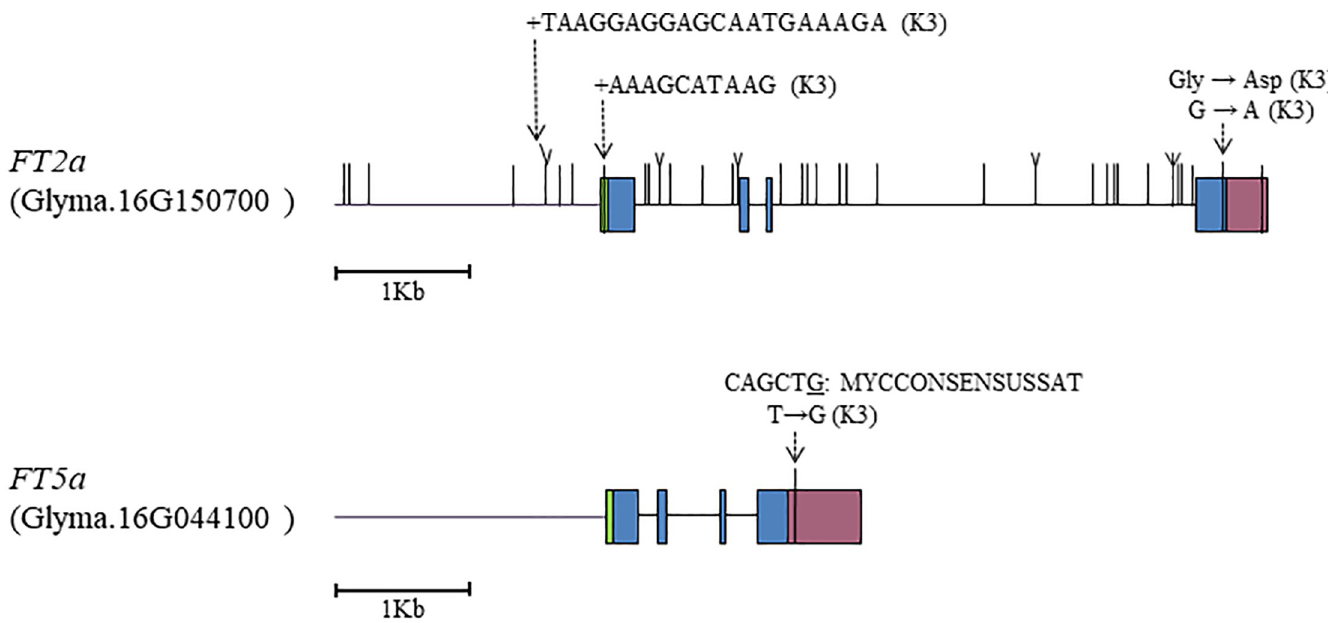
Fig 5. DNA polymorphisms in FT2a and FT5a between soybean lines AGS292 and K3. AK16 possessed the alleles from K3 at both the FT2a and FT5a loci. Lines indicate SNPs and indels of 1 to 9 bp. Detailed DNA polymorphisms are provided in S3 Table. Green, blue and purple boxes indicate 5 0 UTR, exon and 3 0 UTR,